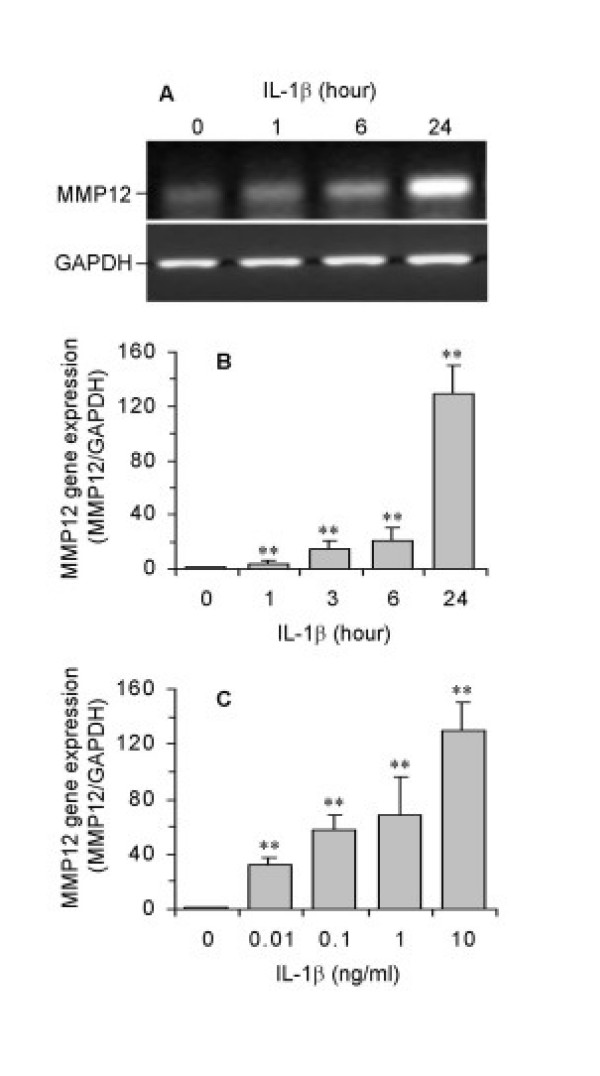
Stimulation of MMP-12 mRNA expression by IL-1β in ASMC. Cells were incubated in the absence or presence of IL-1β at 10 ng/ml for 1–24 hours (A, B), or for 24 hours over 0.01 to 10 ng/ml (C). MMP-12 and GAPDH mRNA expression was analysed by RT-PCR (A) or real-time RT-PCR (B,C). Results (B,C) were expressed as a ratio of target gene to GAPDH mRNA control and are the mean ± SEM from three ASMC donors. **P < 0.01 compared with control.